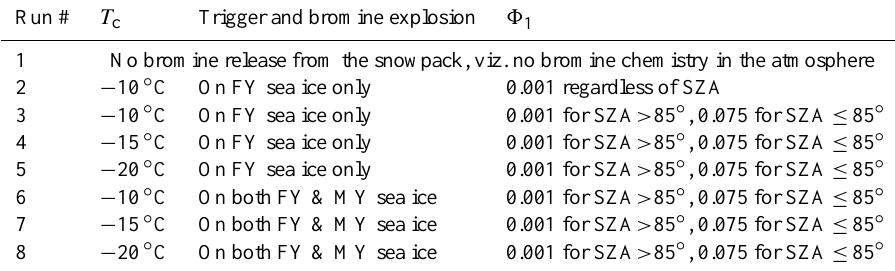
Table 3. Description of model runs: “critical temperature” ( T c ) at and below which the snowpack acquires a capability of releasing Br 2 (2nd column), the type of underlying sea ice where the trigger involving O 3 and the bromine explosion involving HOBr and BrONO 2 are assumed to occur (3rd column), and the molar yield ( 8 1 ) of Br 2 against the loss of O 3 via dry deposition for the semi-empirical trigger (4th column). Run # T c Trigger and bromine explosion 8 1 1 No bromine release from the snowpack, viz. no bromine chemistry in the atmosphere 2 − 10 ◦ C On FY sea ice only 0.001 regardless of